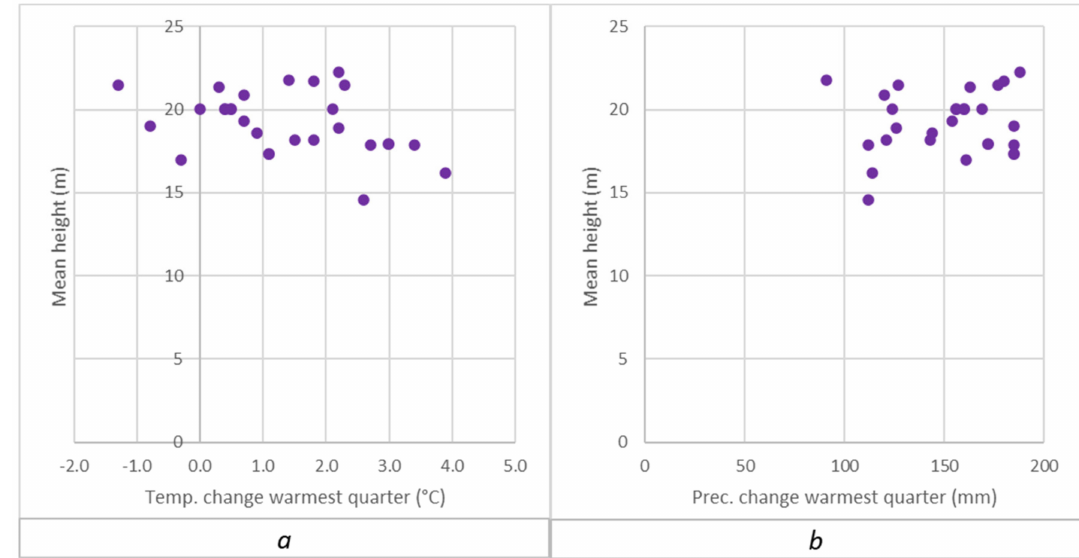
Figure A2. Mean summer temperature ( a ) and precipitation ( b ) change versus mean height of grand fir provenances at the age of 36 years, in the trial 213, Zbiroh. Note that nearly all populations were transferred into a warmer summer climate with higher rainfall.